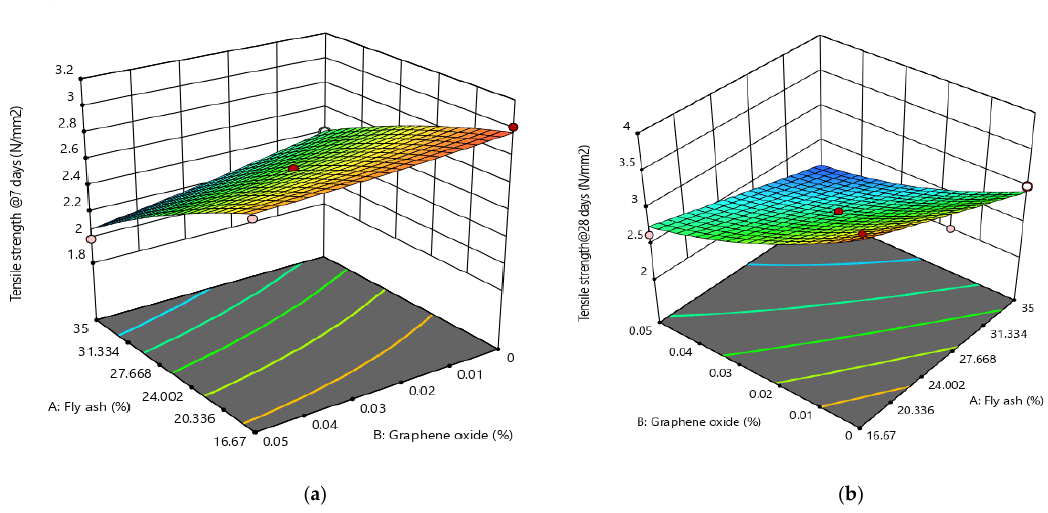
Figure 5. Response surface plots for tensile strength: ( a ) 7 days; ( b ) 28 days. In above equation, F ST represents the 28-day splitting tensile strength in MPa, and A and B represent the amount of fly ash and graphene oxide, respectively, in percentage (%). 3.4. Flexural Strength Figure 6 represents the flexural strength (FS) of all the experimental combinations at 28 days. The flexure strength of GO-incorporated FSCC ranges from 4.84 to 9.89 MPa and 5.338 to 10.791 MPa for 7 and 28 days, respectively. Proper dispersion of graphene oxide could reduce the formation of lumps which causes the voids. Thus, it could influence the